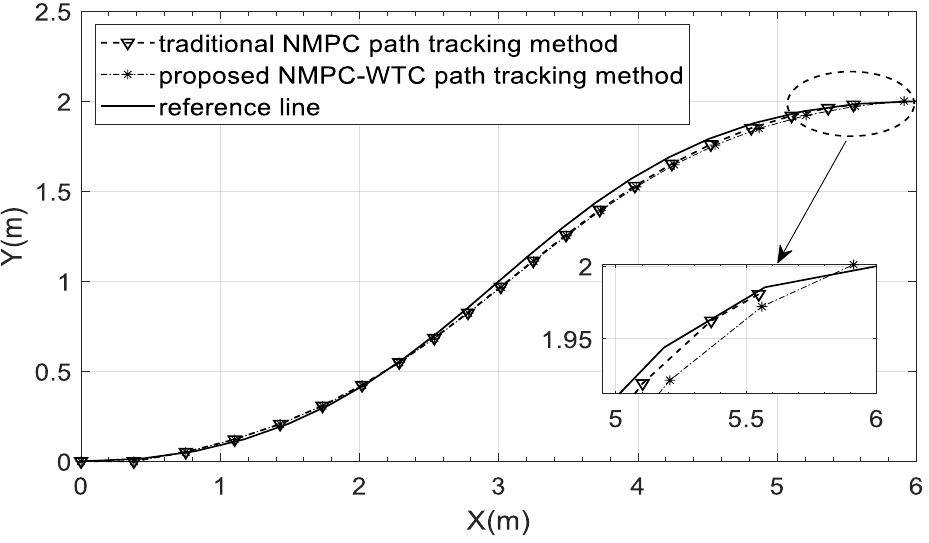
Figure 3. Schematic diagram of vehicle lane changing path tracking.